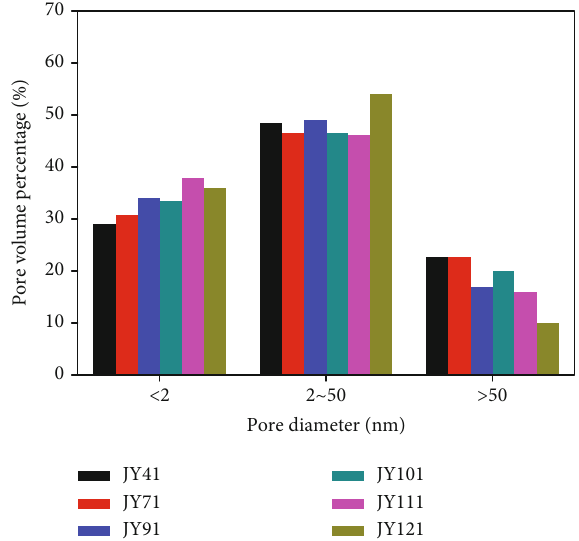
Figure 6: Pore volume percentage of gas shales derived from nitrogen adsorption